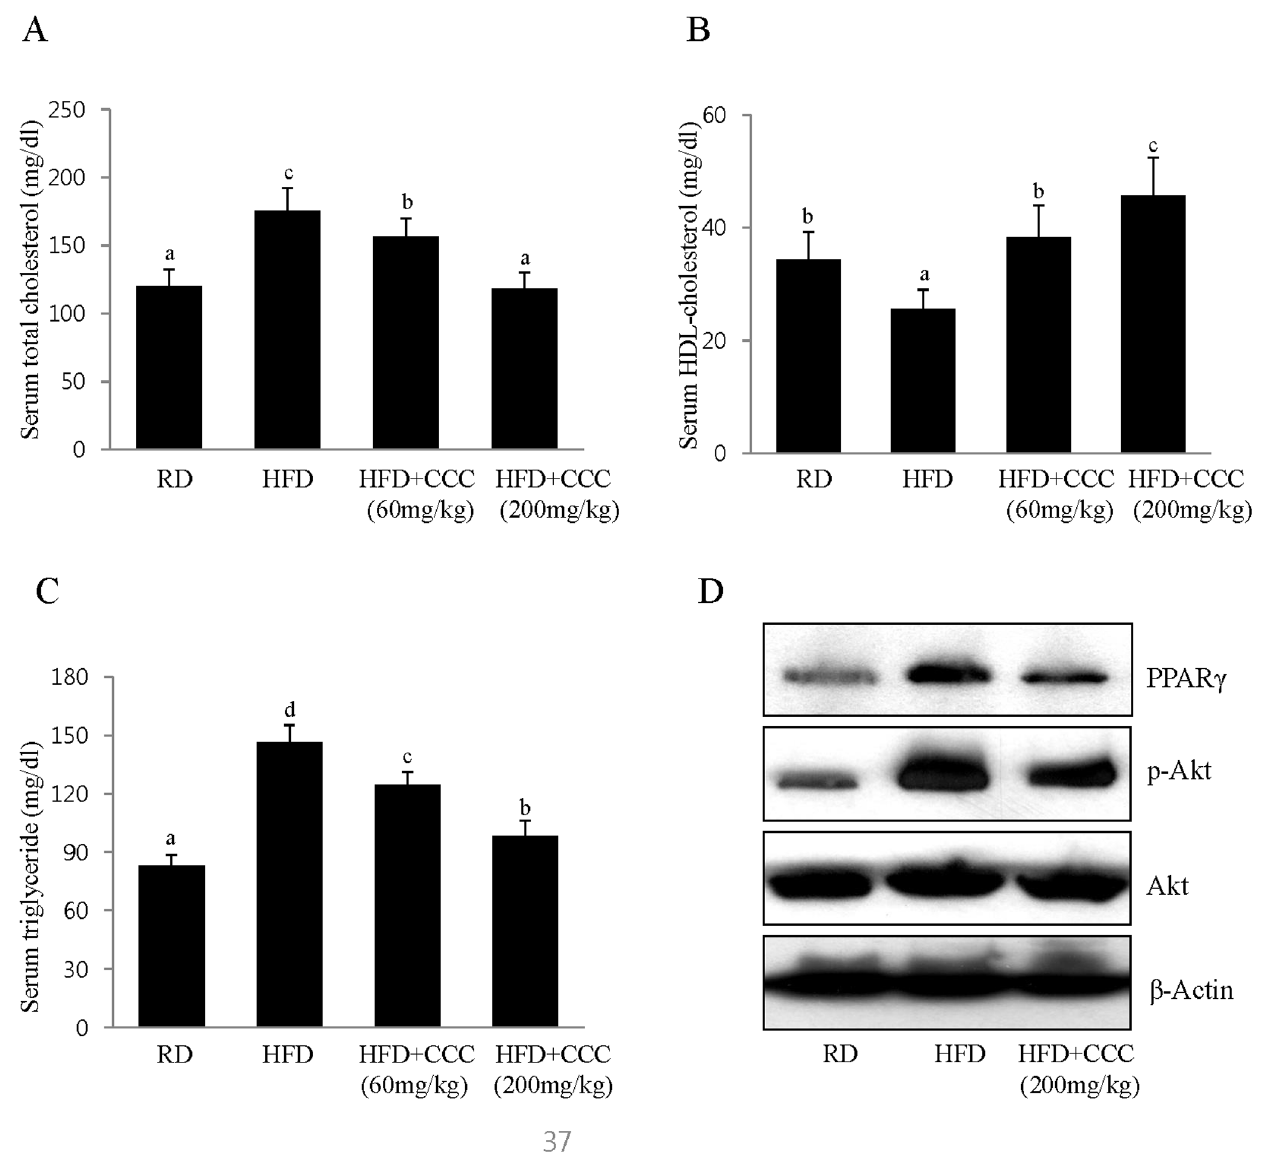
Figure 5. Effect of CCC on the lipid contents of the HFD-induced obese rats. (A, B, C) Significant decreases in the levels of serum triglycerides and total cholesterol were observed in the CCC-treated groups compared to the HFD-induced obese rats. HDL-cholesterol levels in the CCC groups were increased compared to the HFD group. The values are expressed as the mean 6 SD. The bars showing different letters indicate significant differences among each group of bars, according to Duncan’s test; *P , 0.05. (D) CCC reduced the phosphorylation of Akt and the expression of PPAR c in the HFD-induced obese rats. PPAR c and phospho-Akt protein expression in the epididymal fat tissue was determined by western blot